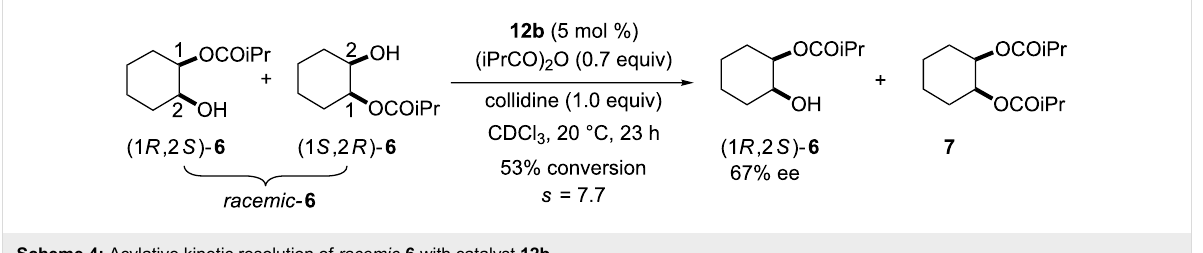
Scheme 4: Acylative kinetic resolution of racemic - 6 with catalyst 12b